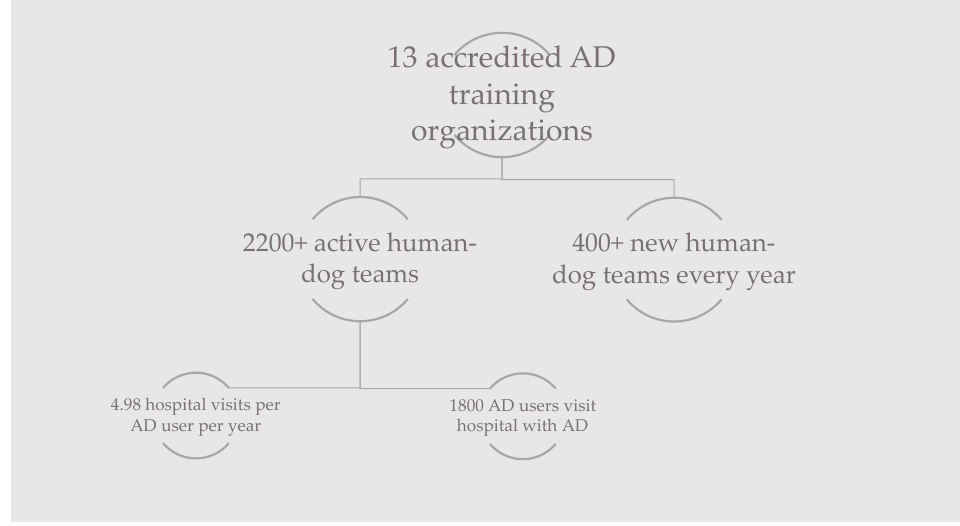
Figure 9. Summary of the numbers regarding assistance dog (AD) training organisations and the AD users of the Nether- lands.